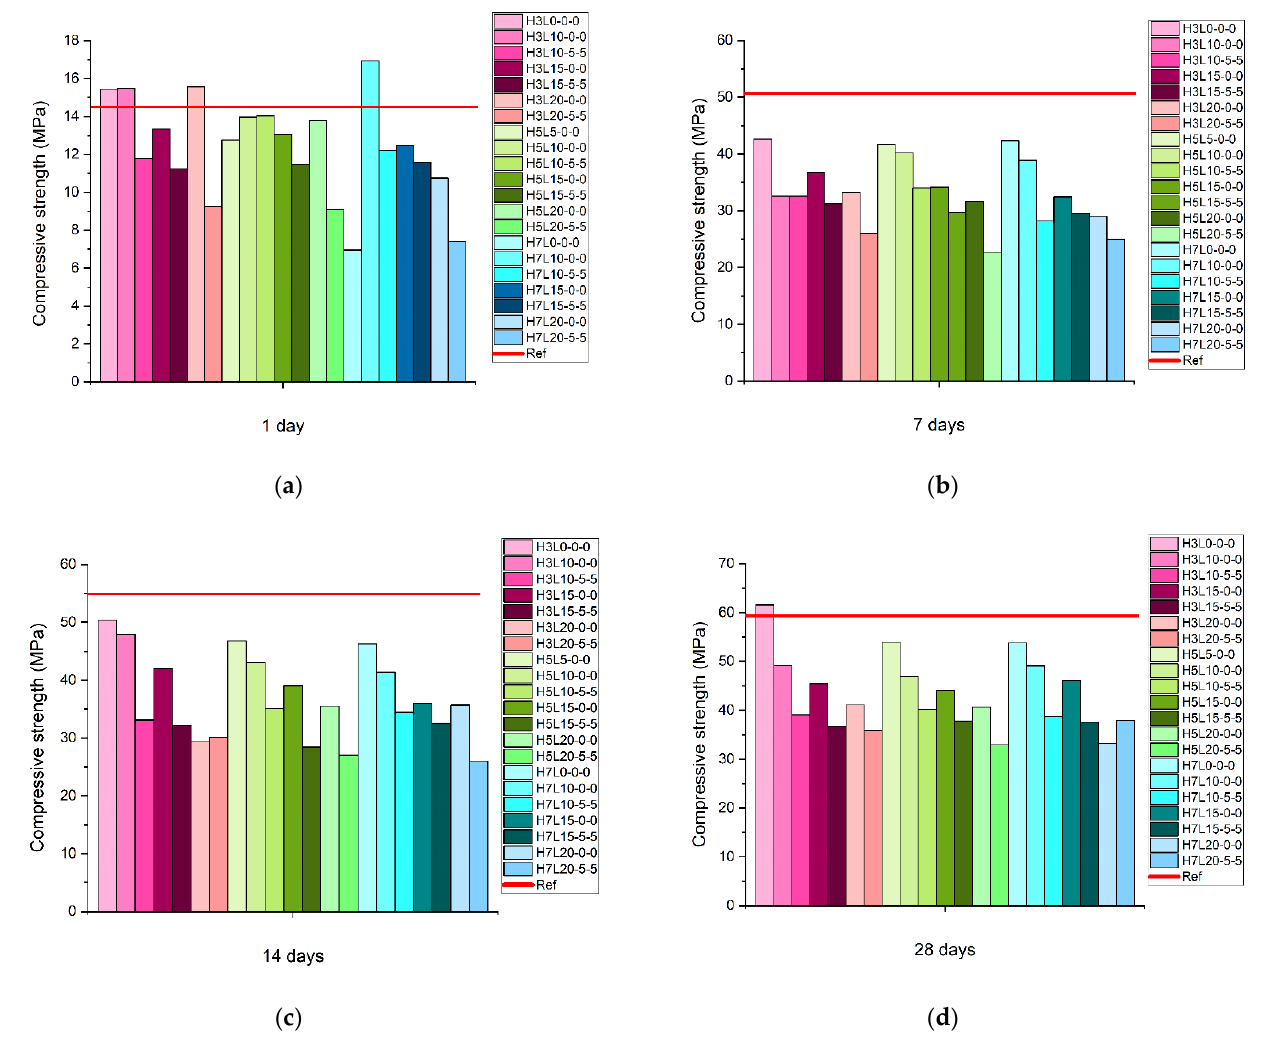
Figure 3. Compressive strength of mortars made with limestone and three contents of coarse silica fume (3%, 5% and 7%) at: ( a ) 1 day, ( b ) 7 days, ( c ) 14 days, and ( d ) 28 days.